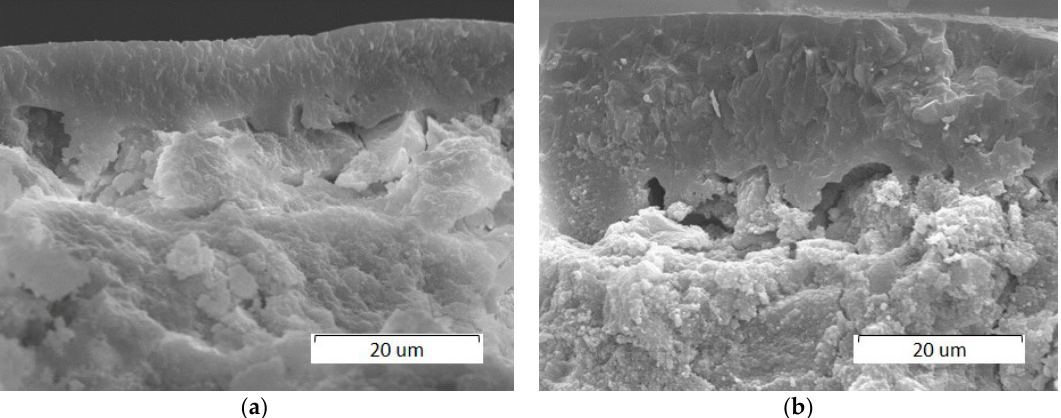
Figure 6. SEM images of cross sections of HA pellets treated by a 0.25 mm laser spot at a power of 4 W and at different scanning speeds: ( a ) 200 mm/s; ( b ) 100 mm/s.